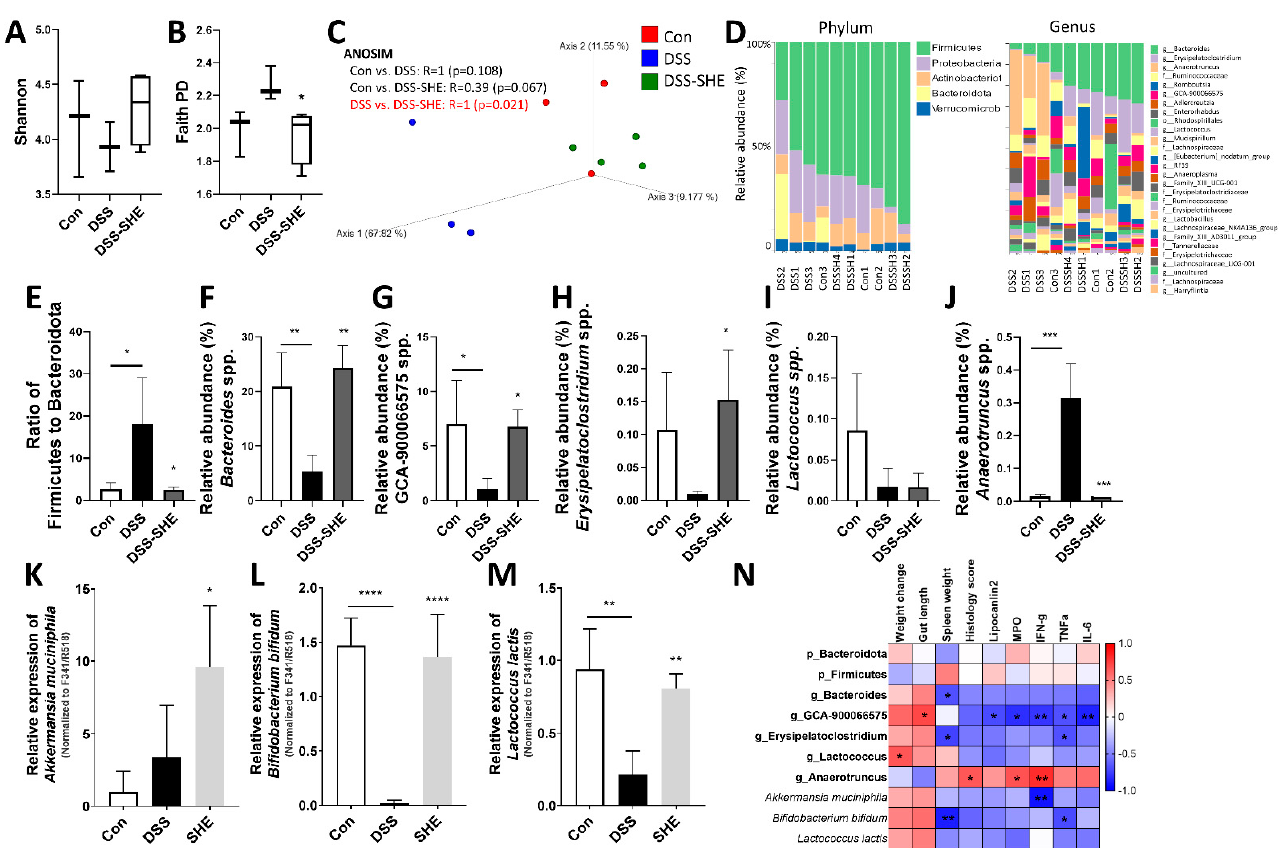
Figure 7. Effects of S. horneri extract (SHE) on the composition of the gut microbiota in DSS-treated mice. ( A ) Shannon index, and ( B ) Faith’s phylogenetic diversity (PD). ( C ) Principal coordinate analysis (PCoA) of weighted UniFrac distances. ( D ) Analysis of the taxonomy community at the phylum and genus levels. ( E ) The Firmicutes to Bacteroidota ratio. ( F – J ) Taxa whose relative abundance changed as a result of DSS or DSS-SHE treatment. (n = 3 or 4; fecal DNA from 2 mice was combined for 16S sequencing in a single sample). ( K ) Quantitative PCR for Akkermansia muciniphila , ( L ) Bifidobacterium bifidum , and ( M ) Lactococcus lactis . The abundance of bacterial groups was quantified as a ratio of total bacteria (F341/R518). All data are expressed as means ± SD ( n = 8/group). * p < 0.05, ** p < 0.01, *** p < 0.001, **** p < 0.0001 using a nonparametric Kruskal–Wallis test. ( N ) Spearman correlation analysis of gut microbial species and inflammation-related index (* p < 0.05, ** p < 0.01). CON: control group; DSS: 2.5% DSS in drinking water for the last 7 days; DSS-SHE: DSS + S. horneri extract high dose group (200 mg/kg bw/day).